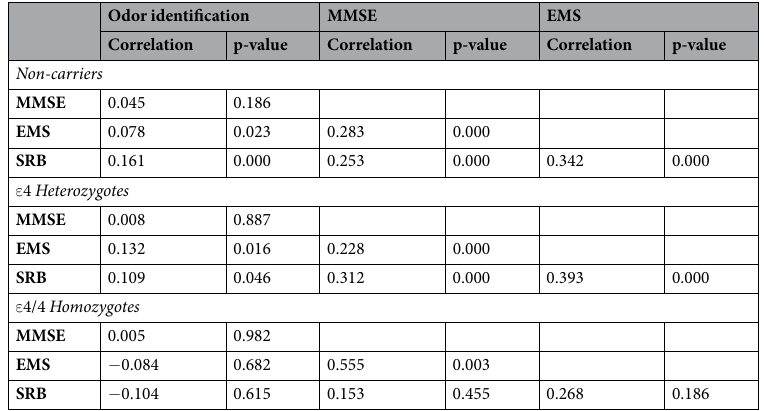
Table 5. Baseline Intercept partial correlations for middle aged and old participants after controlling for demographic covariates; age, sex, education, and an indicator variable to account for potential effects related to previous testing experience (one vs. two